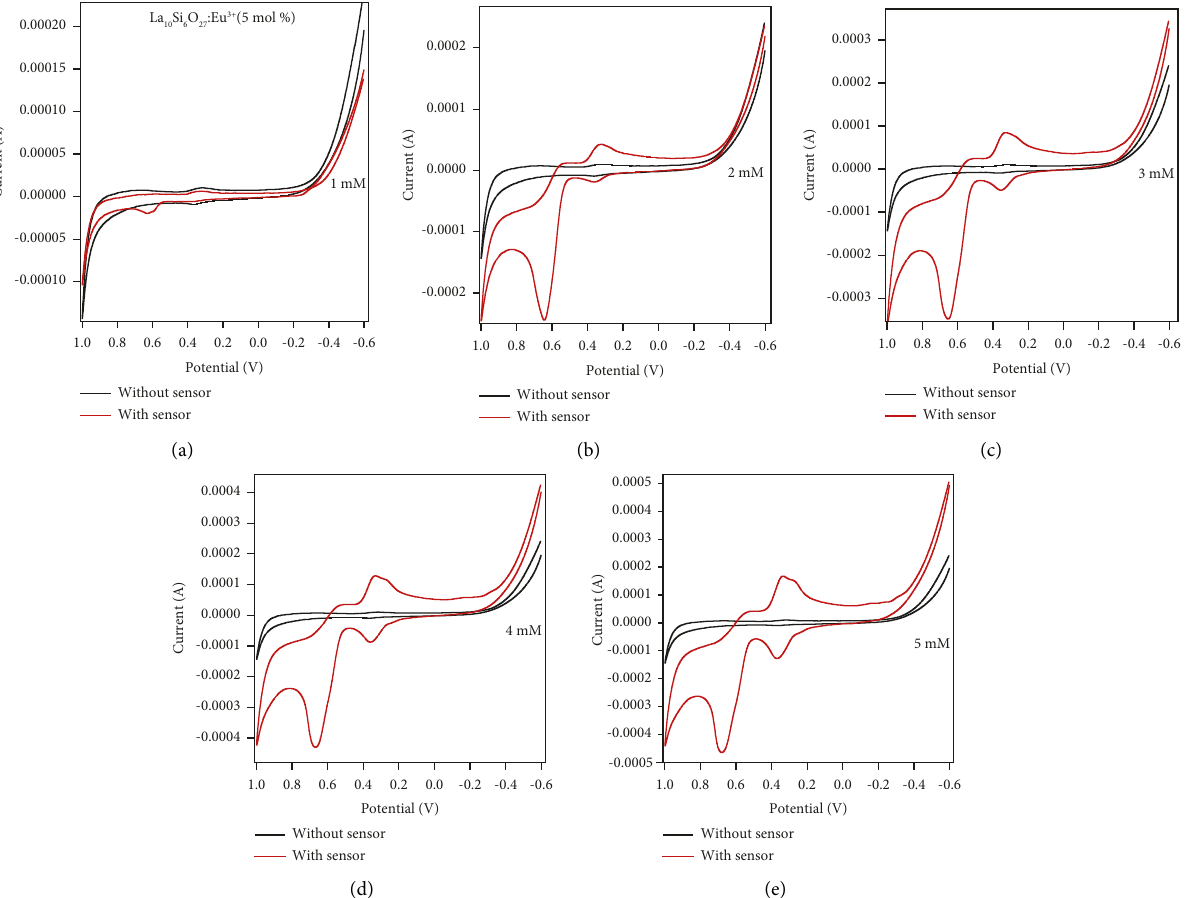
Figure 9: Cyclic voltammogram of La (1–5mM). Table 5: Peak appearance at various potentials during the detection of paracetamol using the La